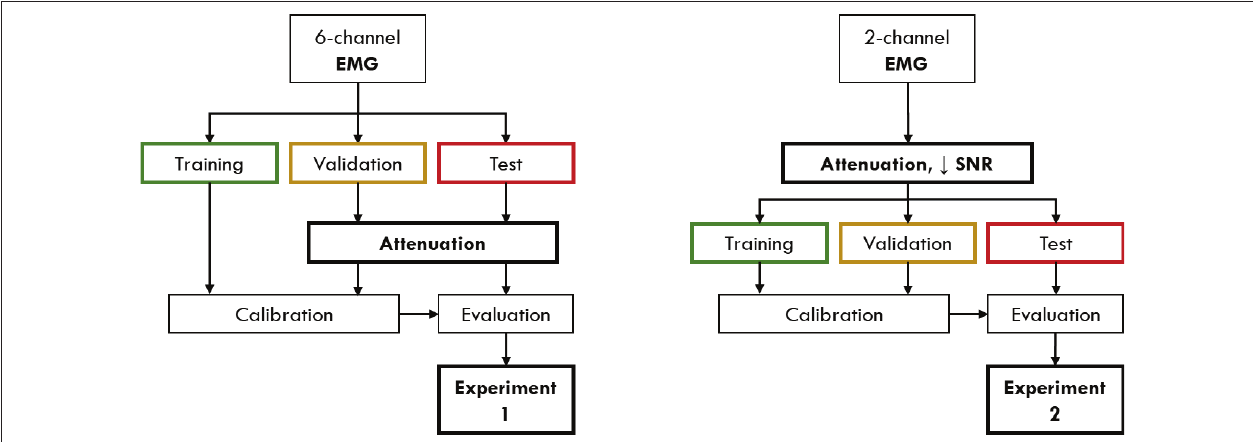
FIGURE 4 | The processing pipeline applied to the EMG signals in order to validate the proposed approach in presence of temporary (Experiment 1) or permanent (Experiment 2) conditions of EMG alteration. In the first condition, signal attenuation is applied only to the validation and test set, while the original training set is used to calibrate the classifier. In the second experiment, signal attenuation and reduced signal-to-noise ratio (SNR) are applied on the entire EMG dataset, in order to simulate a steady condition of